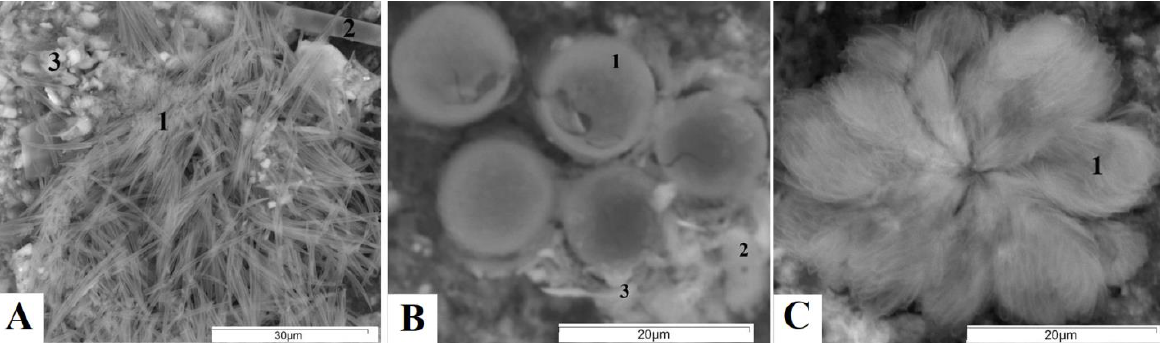
Figure 7. SEM photos: ( A ) suspended matter of the Shuya River filter: 1 — earthy aggregates of rhodochrosite, 2 — quartz, 3 — shells and biodetrite of diatoms and 4 — plagioclase (10 – 30% anor- thite); ( B )suspended matter of the Kumsa River filter: 1 — pollen and 2 — numerous species of dia- toms.